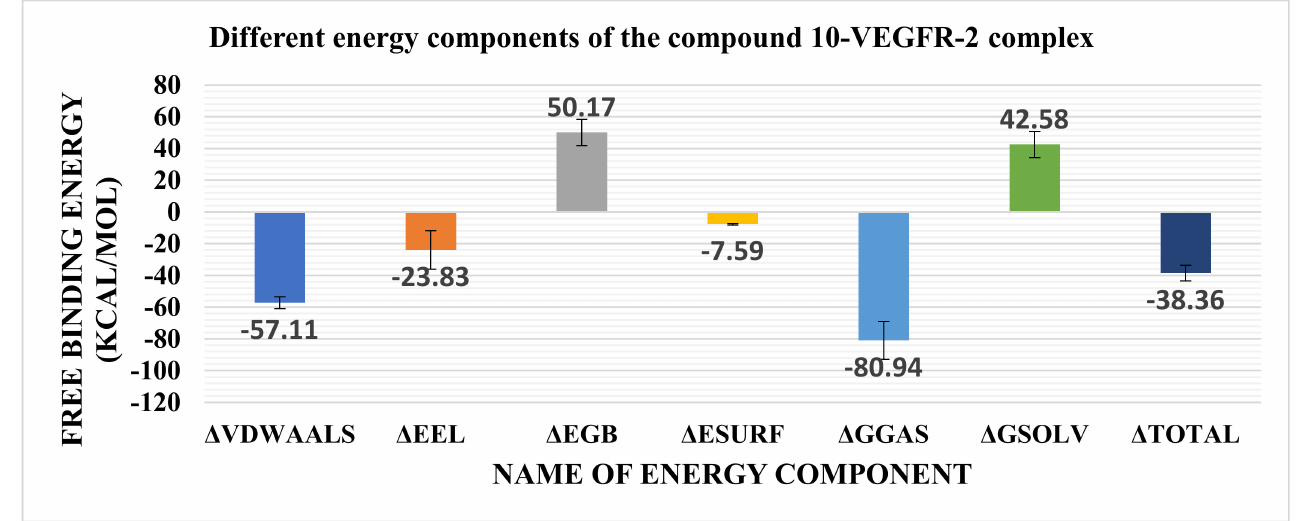
Figure 7. Energy components according to MMGBSA analysis. Bars represent the standard devia- tion